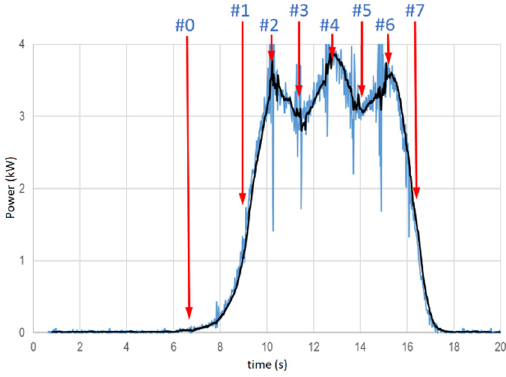
Figure 24. Power transferred to the battery in different pickup positions.